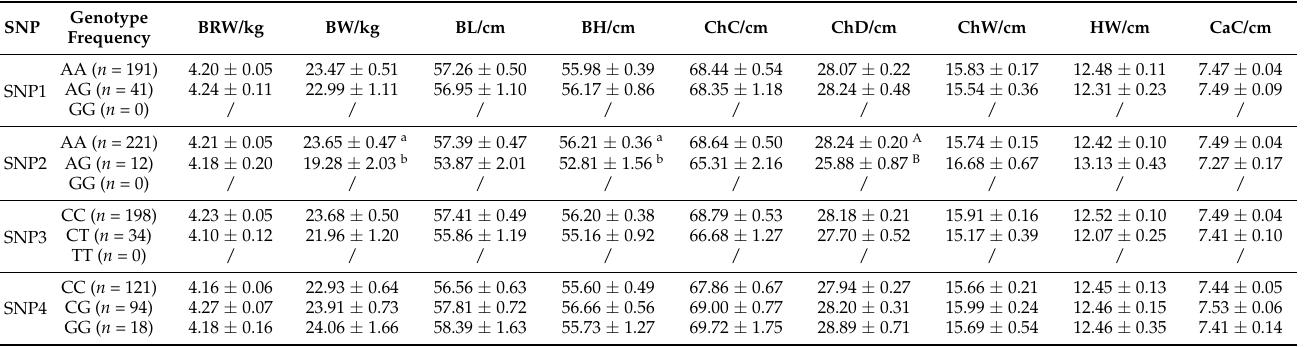
Table 3. Association analyses of SNPs and genotypes in SSTR1 with growth traits of Hulun Buir sheep at birth and weaning 1 .